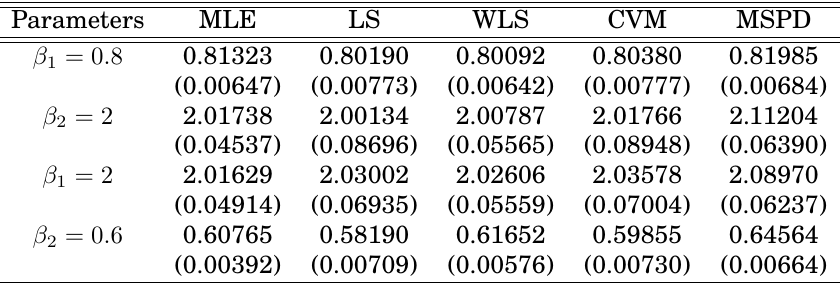
Table 1: AVs and MSEs for ς = 50 .